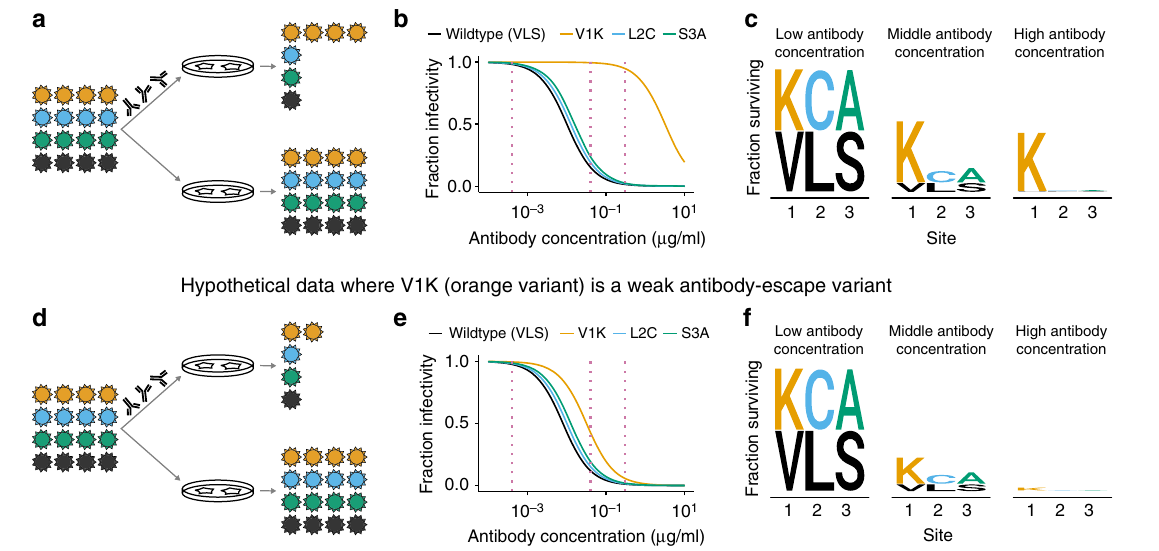
Fig. 1 Quantifying the fraction of virions with each mutation that escape antibody neutralization. This fi gure shows hypothetical data for four viral variants. a Virions with the V1K mutation (orange) completely survive an antibody concentration where most other virions are neutralized. b This resistance is manifested by a large shift in V1K ’ s neutralization curve. c For each dotted vertical line drawn through the neutralization curves in b , we calculate the fraction of virions with that mutation that survive the antibody, and indicate this fraction by the height of the letter corresponding to that amino acid at that site. d – f Similar data to the fi rst three panels, but now V1K has only a small antigenic effect, and modestly increases the fraction of virions that survive antibody